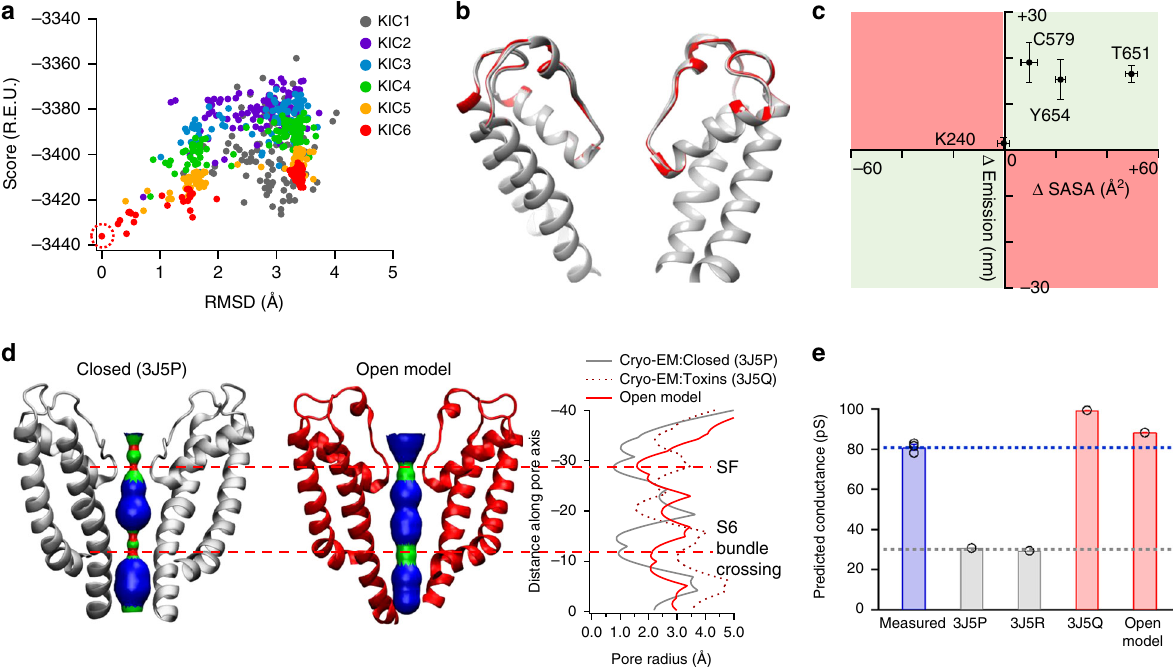
Fig. 3 Modeling of the capsaicin-induced fully open state. a The models after six rounds of KIC loop modeling exhibited a funnel-shaped distribution of total energy calculated by Rosetta (R.E.U., Rosetta energy unit). b Top fi ve models after the sixth round of loop modeling were well converged. The model with the lowest energy (red) was chosen as the open-state model. c Correlation between shifts in ANAP emission peak ( y axis) and changes in SASA measured from our open-state model ( x axis); n = 5 – 7. d Distribution of pore radii in the cryo-EM-derived closed state (3J5P) and our open-state model. In our model, both the selectivity fi ler region and the S6 bundle crossing are wide enough to allow permission of water molecules and ions. e Conductance of TRPV1 in different states predicted by the HOLE program. Our open-state model was predicted to have similar conductance as values measured by patch- clamp recording with 10 µ M capsaicin 17 (the bar in blue). The DkTx and RTX bound state structure (3J5R) determined by cryo-EM represented a fully open state, which shows a predicted conductance close to that of our open-state model and experimentally measured values. The predicted conductance of either the closed state (3J5P) or capsaicin bound state (3J5R) was much smaller (bars in gray). Data points are shown as circles. All statistical data are given as mean ±